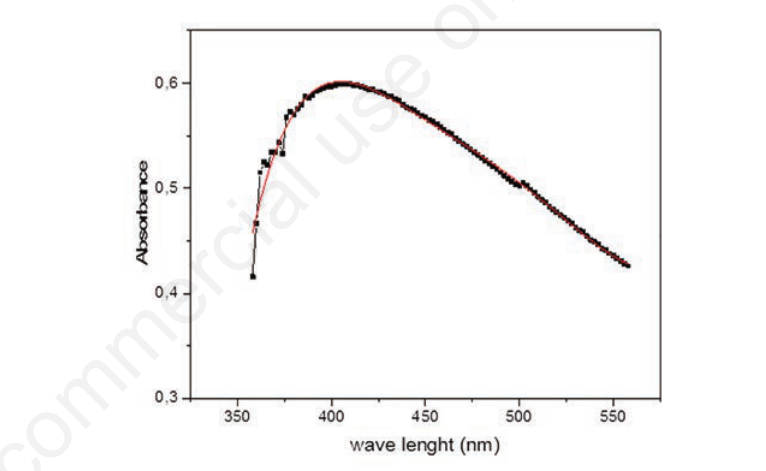
Figure 1. The absorbance results of the S. aureu s